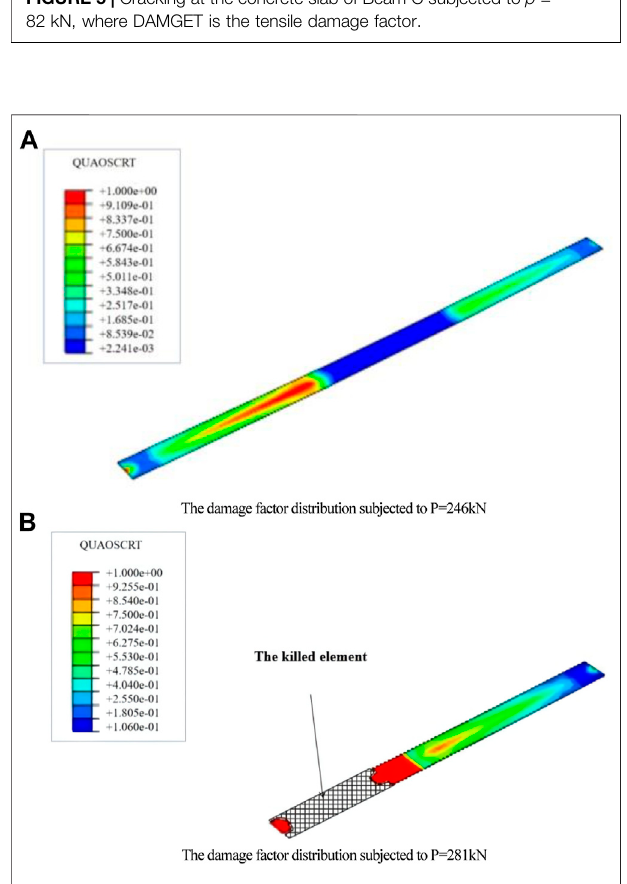
distribution subjected to p = 281